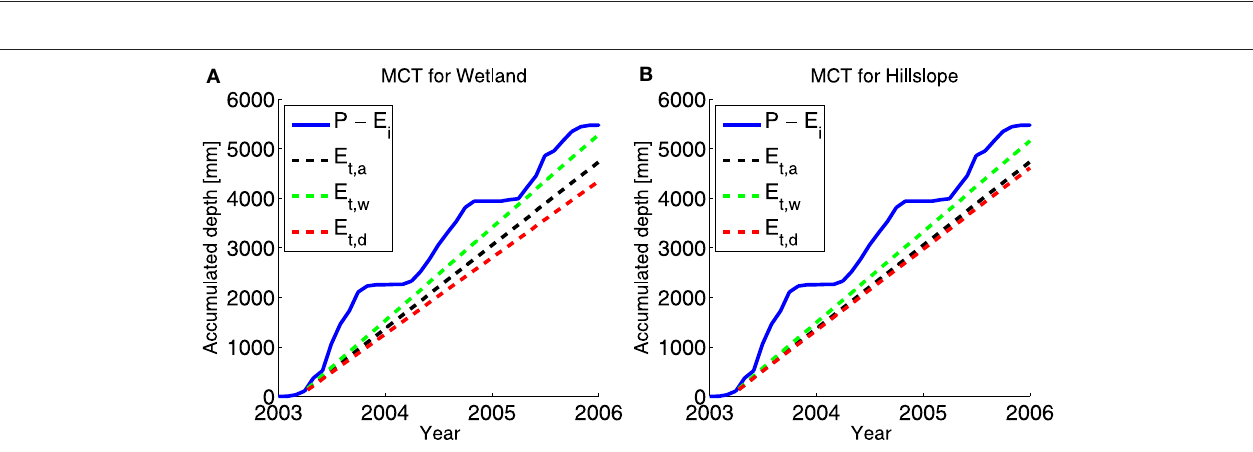
FIGURE 4 | (A) Bandwidth of simulated discharge for the whole parameter space (gray) and the confined parameter space after applying constraints (red), and (B) bandwidth of the reservoir volume for the whole parameter space (gray) and the confined parameter space after applying constraints (red).